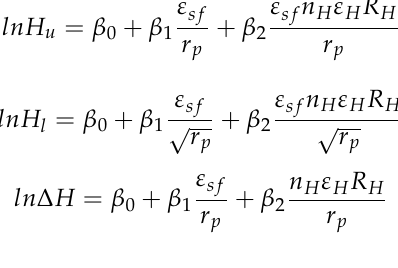
Figure 9. Illustration of a typical simulated sorption isotherm in this work .